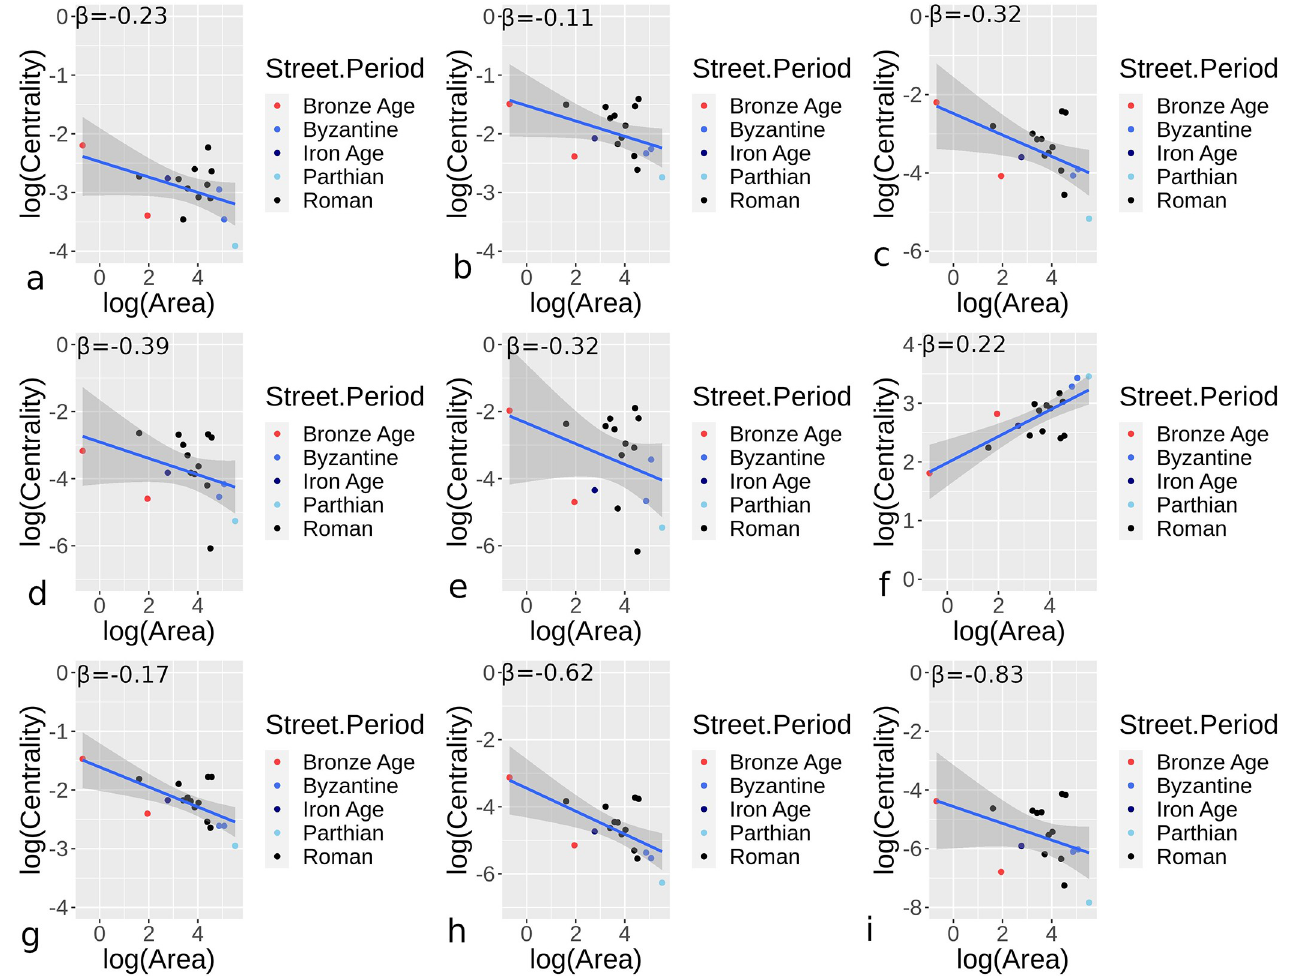
Fig 10. Centrality and scaling values for incomplete street networks for orthogonal and hybrid/organic sites. Results demonstrate betweenness (a), closeness (b), degree (c), efficiency (d), eigenvector (e), harmonic (f), Katz (g), straightness (h), and current flow (i) centrality values.